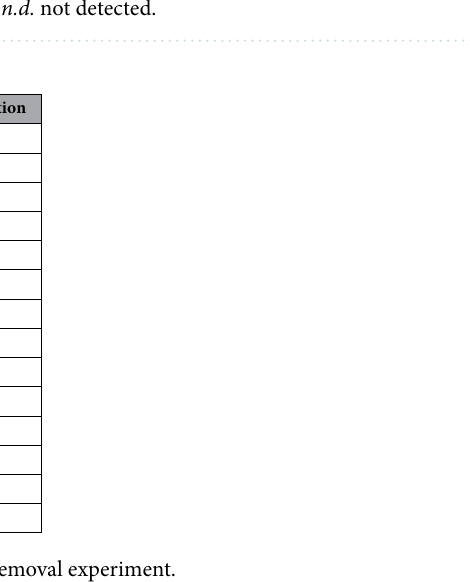
Table 3. Material balance established in this impurity removal